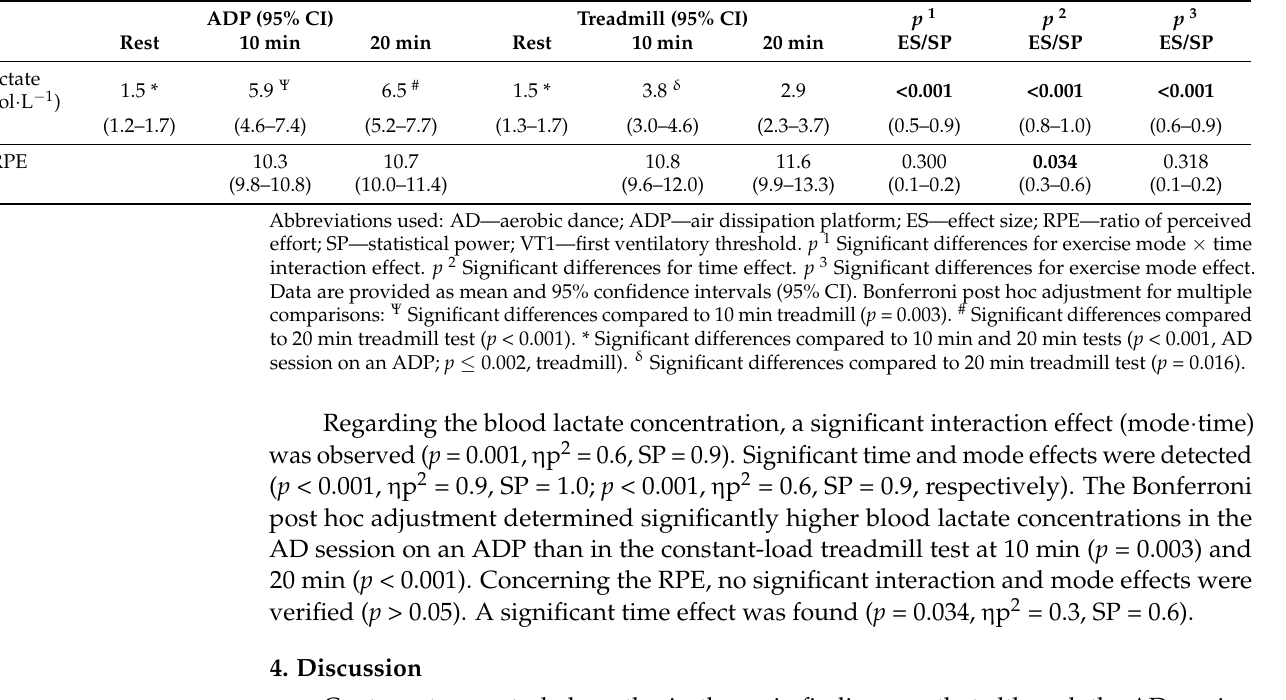
Table 2. Differences in blood lactate concentration and RPE between an AD session on an ADP and a constant-load treadmill test at VT1